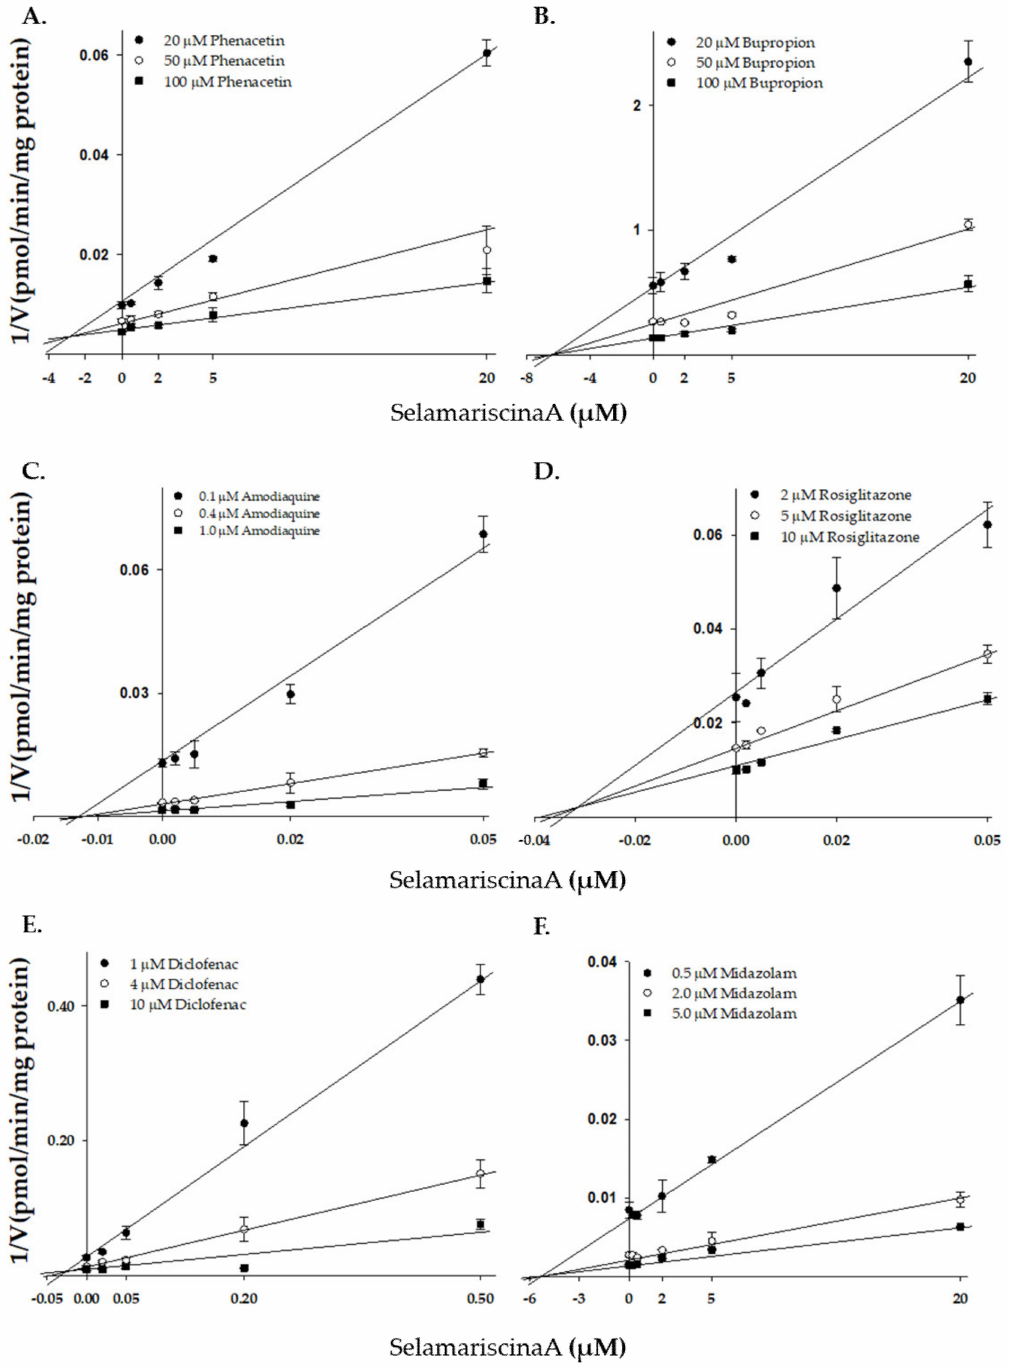
Figure 2. Representative Dixon plots obtained from a kinetic study of CYP1A2-catalyzed phenacetin O -deethylation ( A ), CYP2B6-catalyzed bupropion hydroxylation ( B ), CYP2C8-catalyzed amodiaquine N-deethylation ( C ), CYP2C8-catalyzed rosiglitazone 5-hydroxylation ( D ), CYP2C9-catalyzed diclofenac 4-hydroxylation ( E ), and CYP3A-catalyzed midazolam 1 (cid:48) -hydroxylation ( F ) in the presence of di ff erent concentrations of selamariscina A in pooled human liver microsomes (XTreme 200, XenoTech). Each data point shown represent the mean ± standard error in triplicate for the